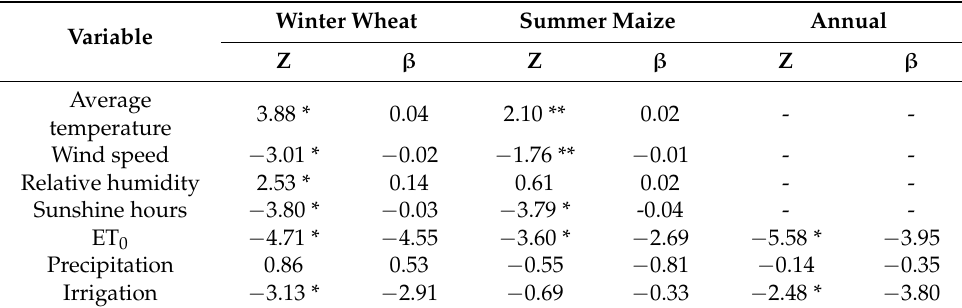
Table 7. Mann–Kendall test and Sen’s slope estimator for climate and irrigation variables during the winter wheat and summer maize seasons from 1969 to 2010.